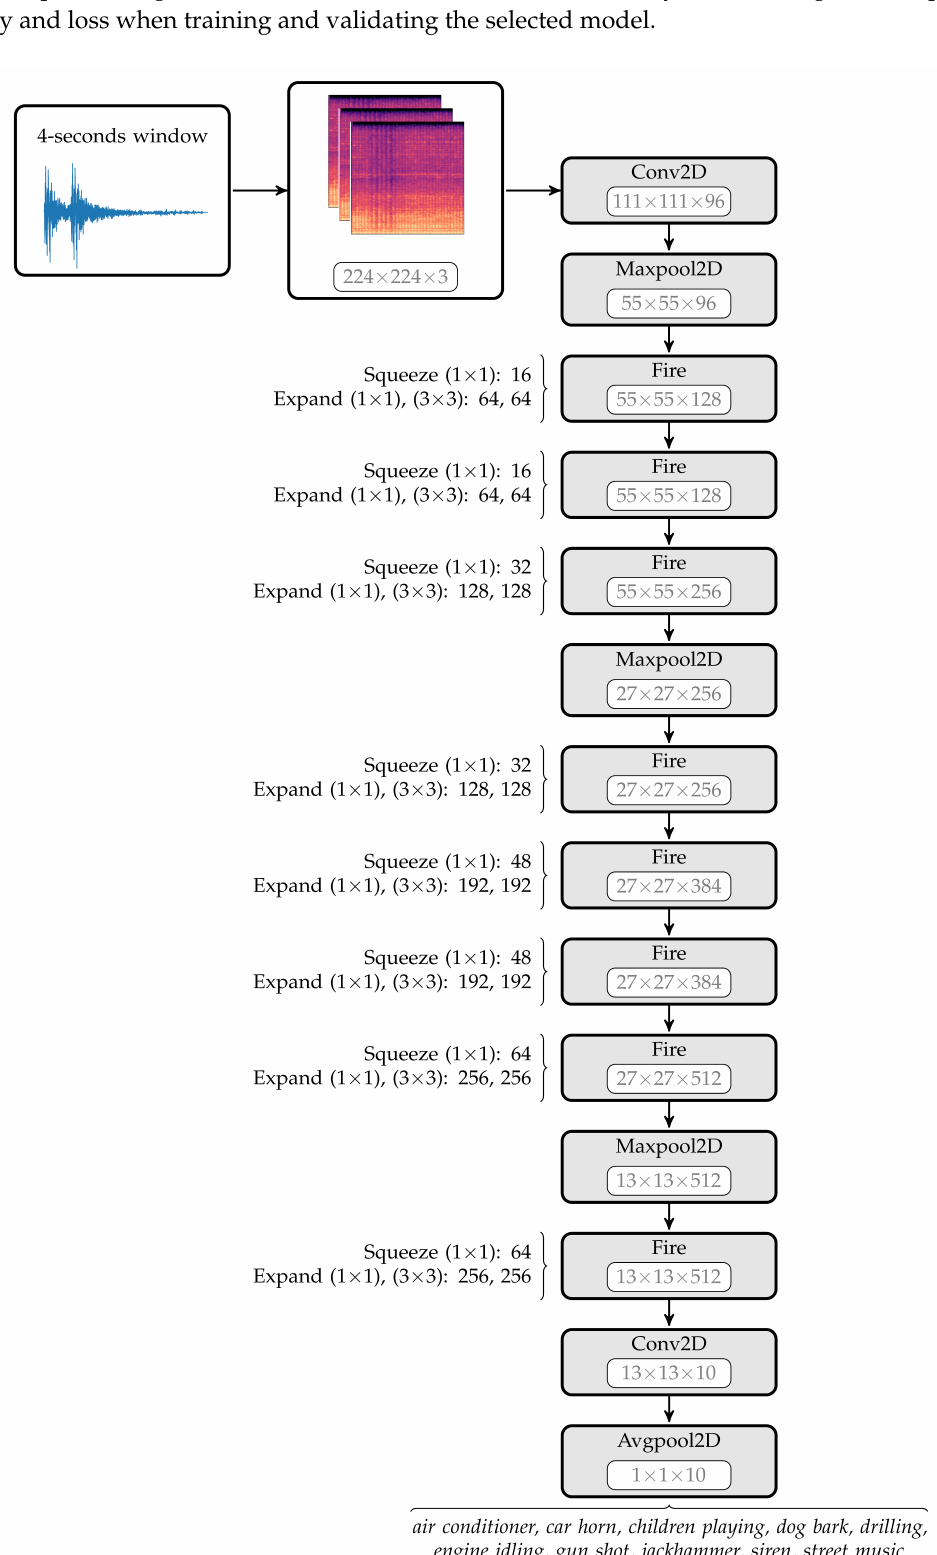
Figure 9. Deep network architecture for the local data